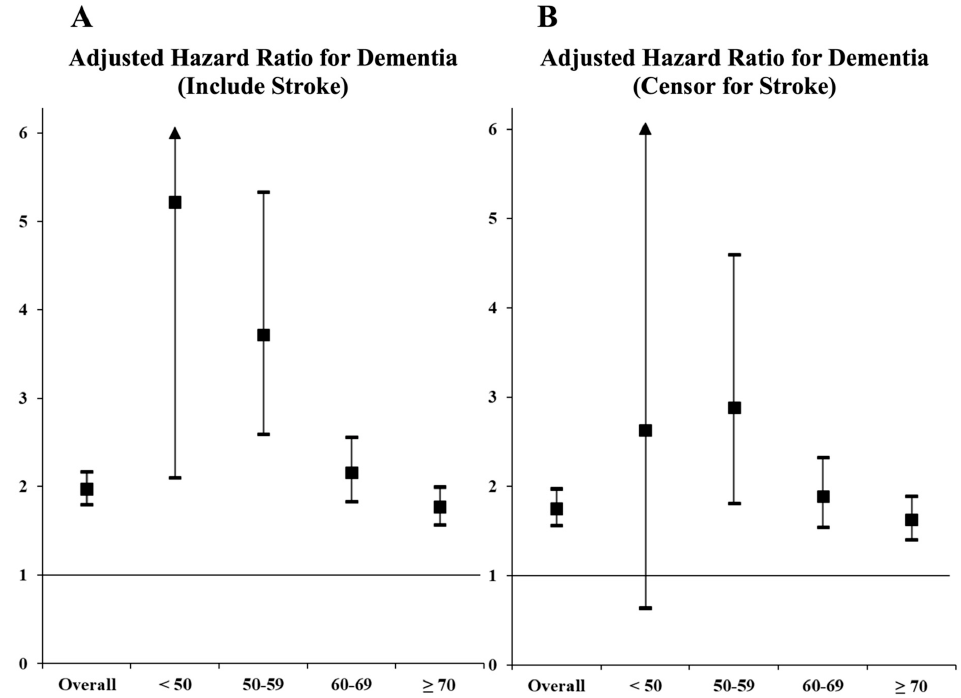
Figure 3. Hazard ratios for dementia per decade of age in the presence of AF. ( A ) Including stroke during the follow-up; ( B ) excluding stroke during the follow-up. The hazard ratios are expressed as boxes, the 95% confidence intervals are expressed as limit lines, and the horizontal line (at hazard ratio 1) indicates no difference in hazard ratios between the AF and the without-AF groups.